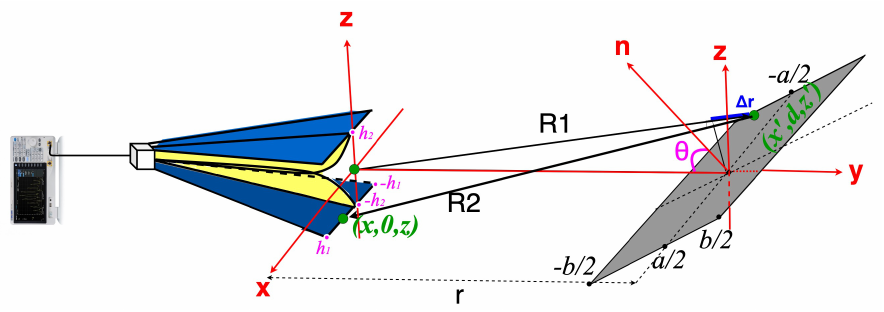
Figure 2. Radar type setup with a single